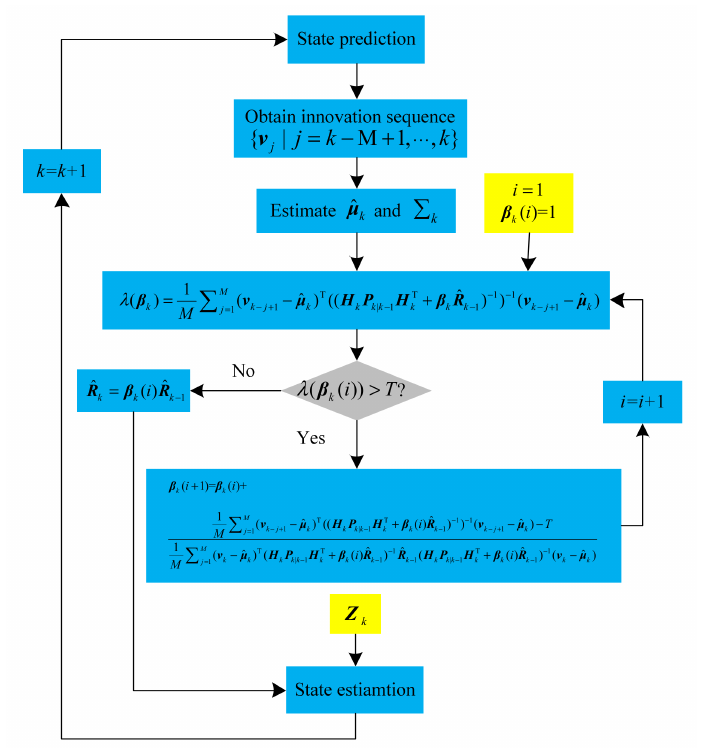
Figure 2. Procedure of the Chi-Square Test-Based Robust Kalman